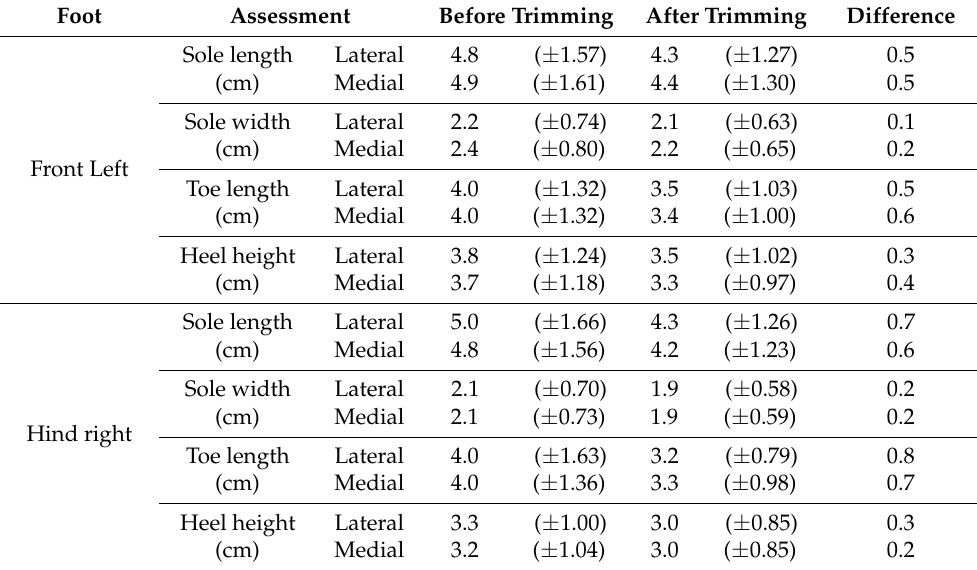
Table 4. Measurements (mean and standard deviation) and differences (in centimeters) of the medial and lateral claw of the front left and hind right foot from 604 goats before and 617 goats after